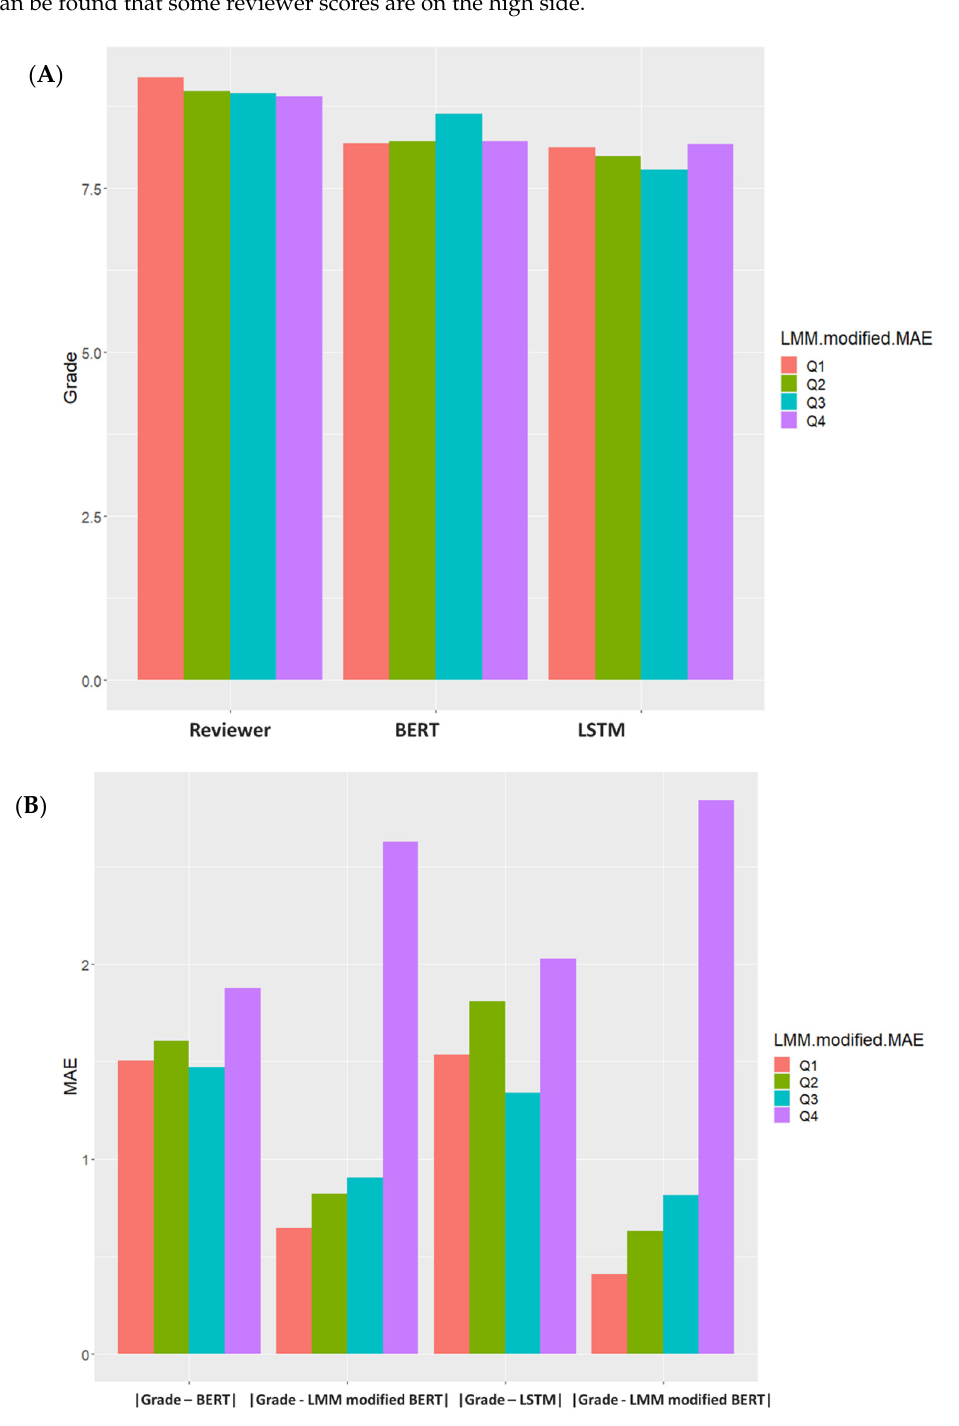
Figure 4. Using LMM modified MAE (Grade-LMM modified LSTM) for interquartile range grouping. ( A ): Compare the scores of Experts, BERT and LSTM. Y -axis: medical record scores, X -axis: Experts’ score, BERT prediction score, LSTM prediction score. ( B ): Compare the original MAE with the LMM modified MAE. Y -axis: mean absolute error (MAE), X -axis: |Grade—BERT|, |Grade—LMM modified BERT|, |Grade—LSTM|, |Grade—LMM modified BERT| for model efficiency evaluation. The LMM modified MAE (Grade-LMM modified LSTM) is grouped by interquartile range and divided into Q1, Q2, Q3, and